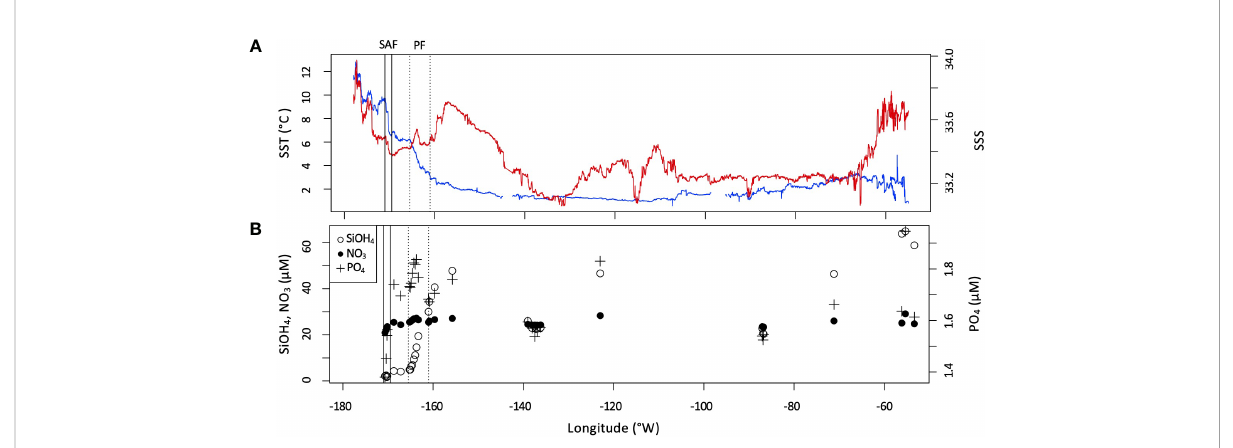
FIGURE 2 (A) Sea surface temperature (SST, blue) and salinity (SSS, red) measured underway across the transect. Ranges of the Sub-Antarctic front (SAF) and Polar front (PF) indicated by solid and dotted vertical bars, respectively. (B) Surface nutrient concentrations (NO 3 , SiOH 4 , and PO 4 ) measured along the transect.